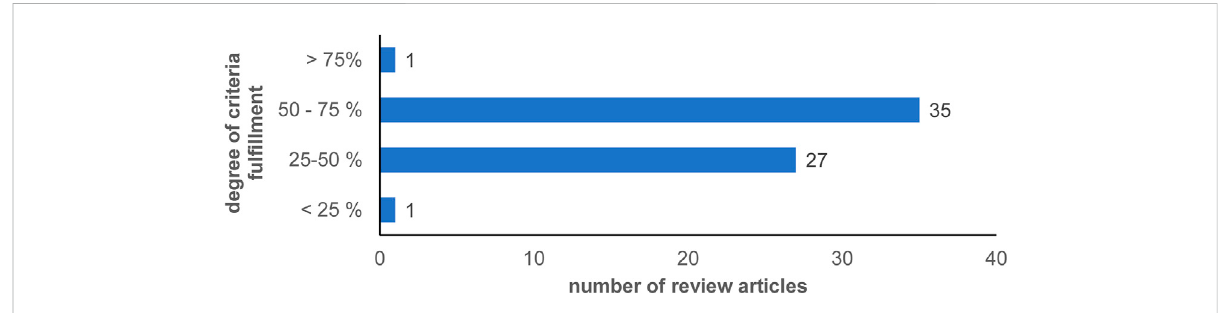
FIGURE 11 Percentageofqualitycriteriametbyreviewarticles(n=64).Mostarticlesful fi lledbetween25and75%oftheelevenqualitycriteriaforassessing search and screening strategy. Only one article ful fi lled more than 75% of the